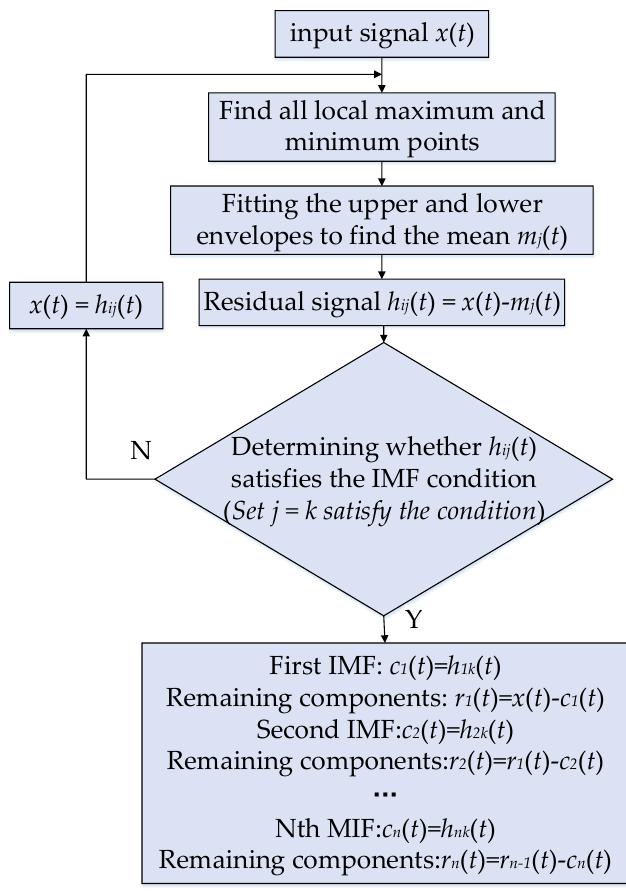
Figure 1. Signal decomposition flow chart of the EMD method. According to the IMF and the residual component r ( t ), the original signal x ( t ) can be reconstructed, as shown in Equation